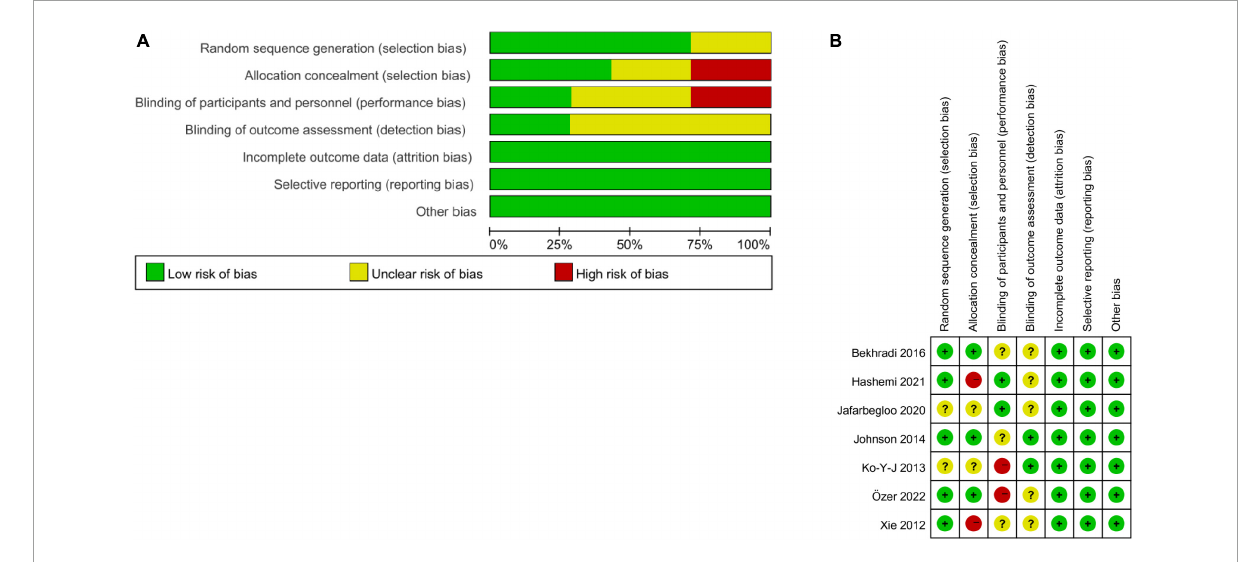
FIGURE2 Risk of bias assessment using the Cochrane tool: (A) overall trials; (B) individual